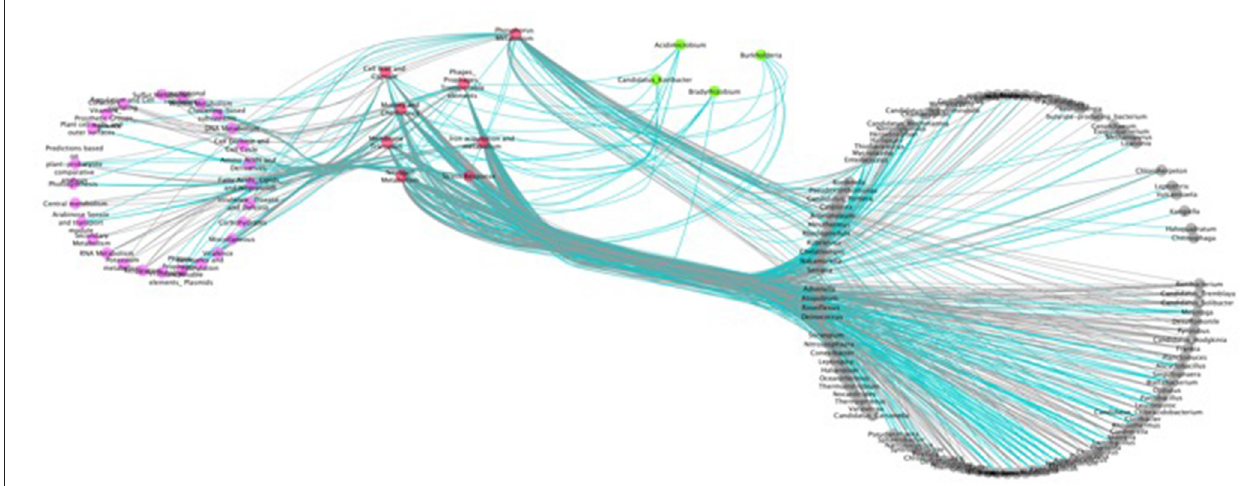
FIGURE 5 | Network analysis of variable interactions with top drivers of taxonomic and functional dissimilarity. All edges are statistically significant ( p < 0.05) based on Maximal Information Coefficient (MIC) score. Pink nodes, metabolic category; dark pink nodes, metabolic categories found to be top drivers of clustering (t -test); gray nodes, taxa (genus); green circles, genera found to be top drivers of clustering ( t -test). Black edges, positive interactions; blue, negative